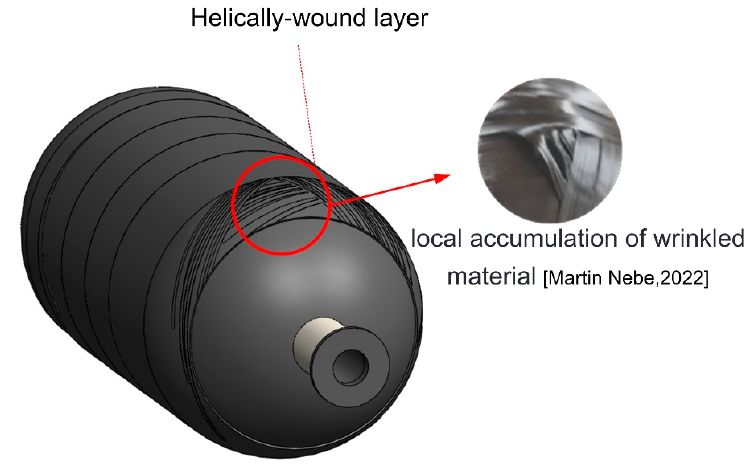
Figure 1. Example of a manufacturing wrinkle defect.